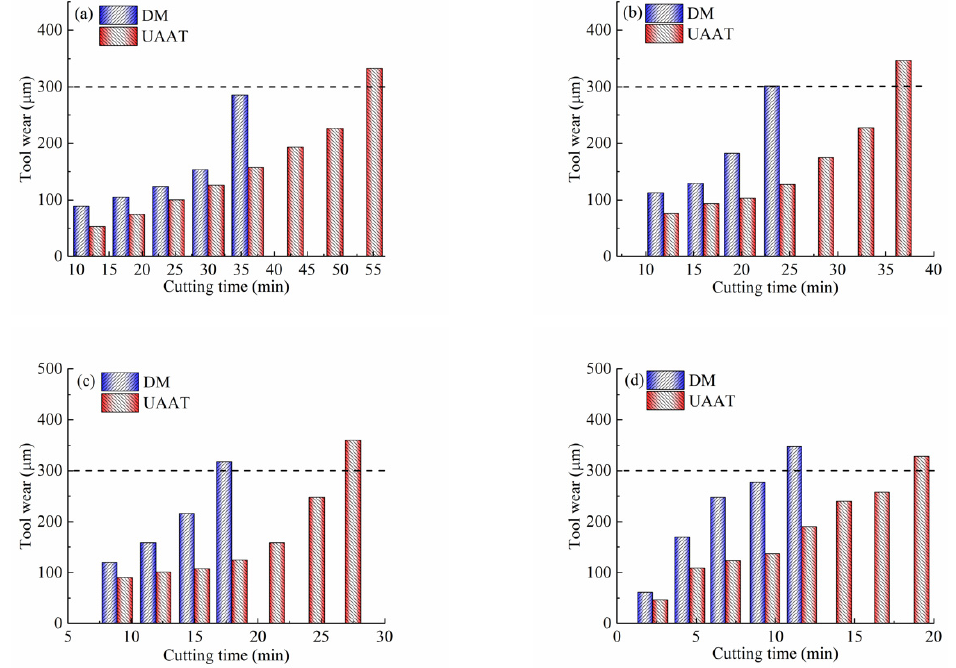
Figure 2. Tool life analysis at four cutting speeds: ( a ) 30 m / min, ( b ) 40 m / min, ( c ) 50 m / min, and ( d ) 60 m / min.